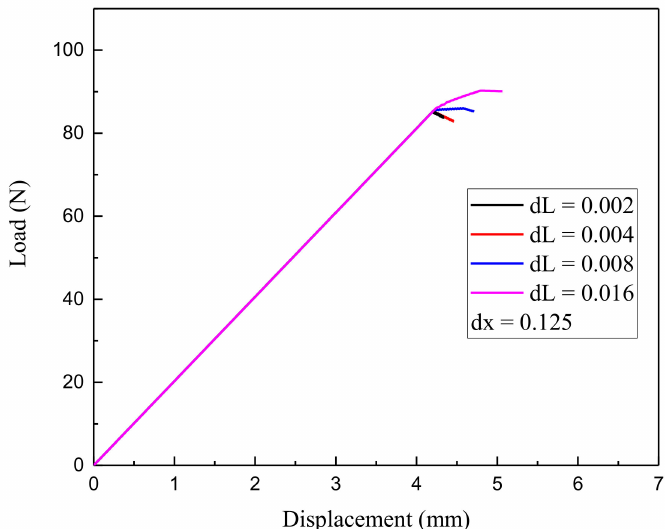
Figure 10. Convergence analysis of loading increment dL for grid spacing dx = 0.125 mm, PD modeling